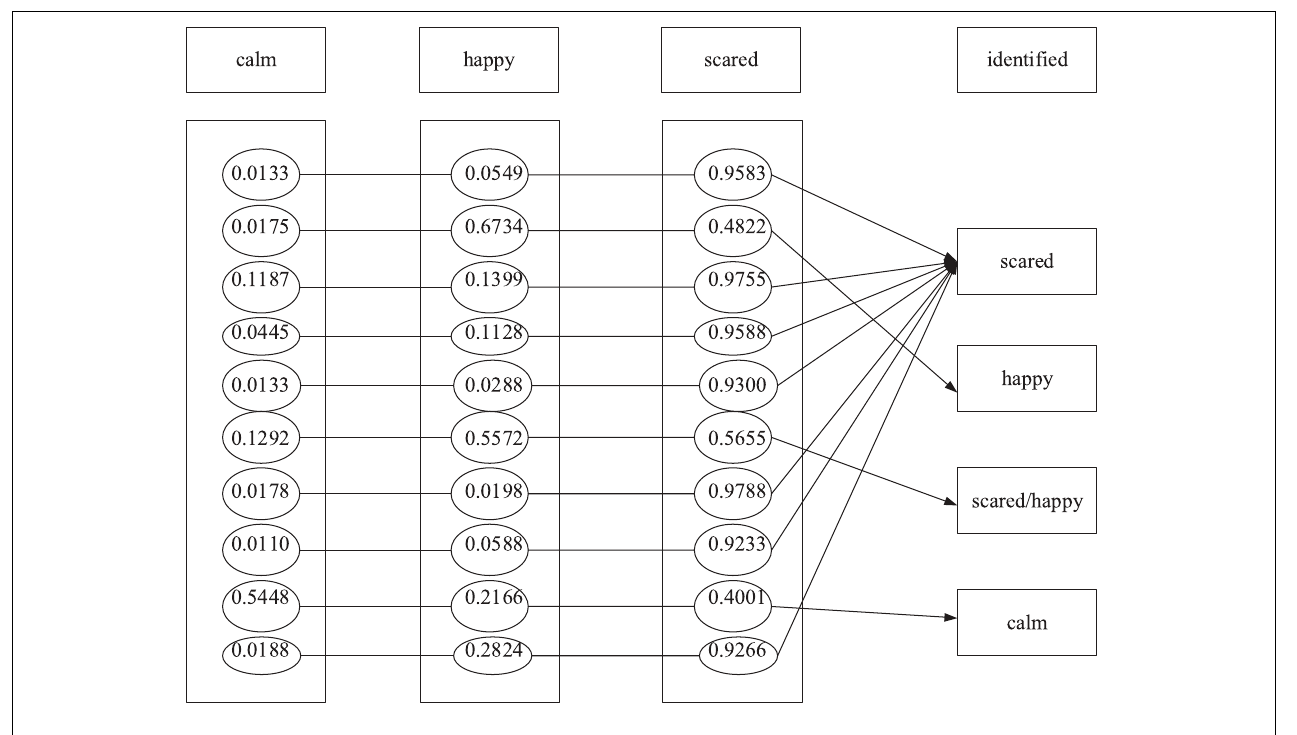
FIGURE 11 | Recognition results under the scared state. TABLE 2 | Development of children’s emotion recognition